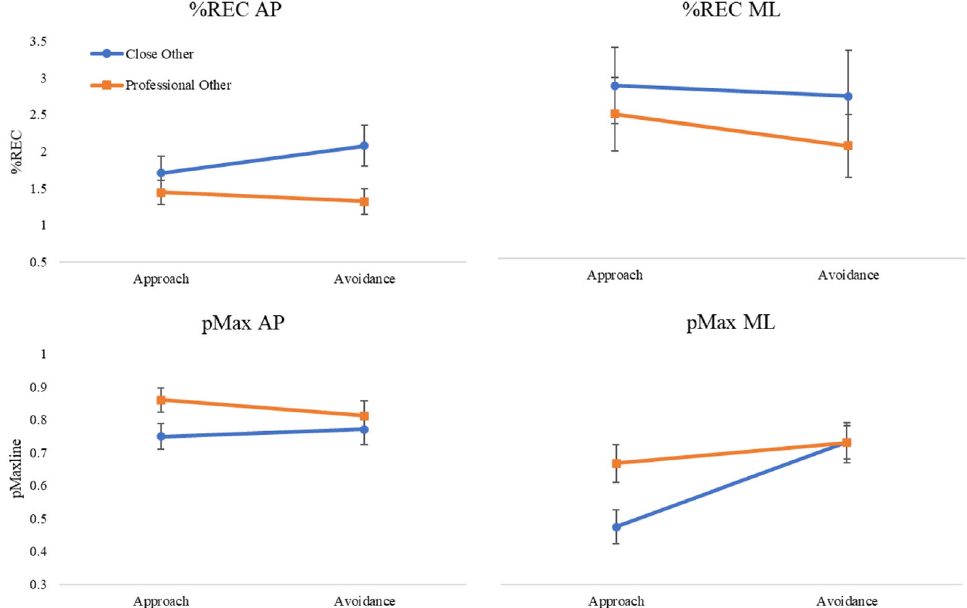
Fig. 5 Results of recurrence quanti fi cation analysis for postural activity. Mean %REC, and pMaxline of postural activity in the ML and AP